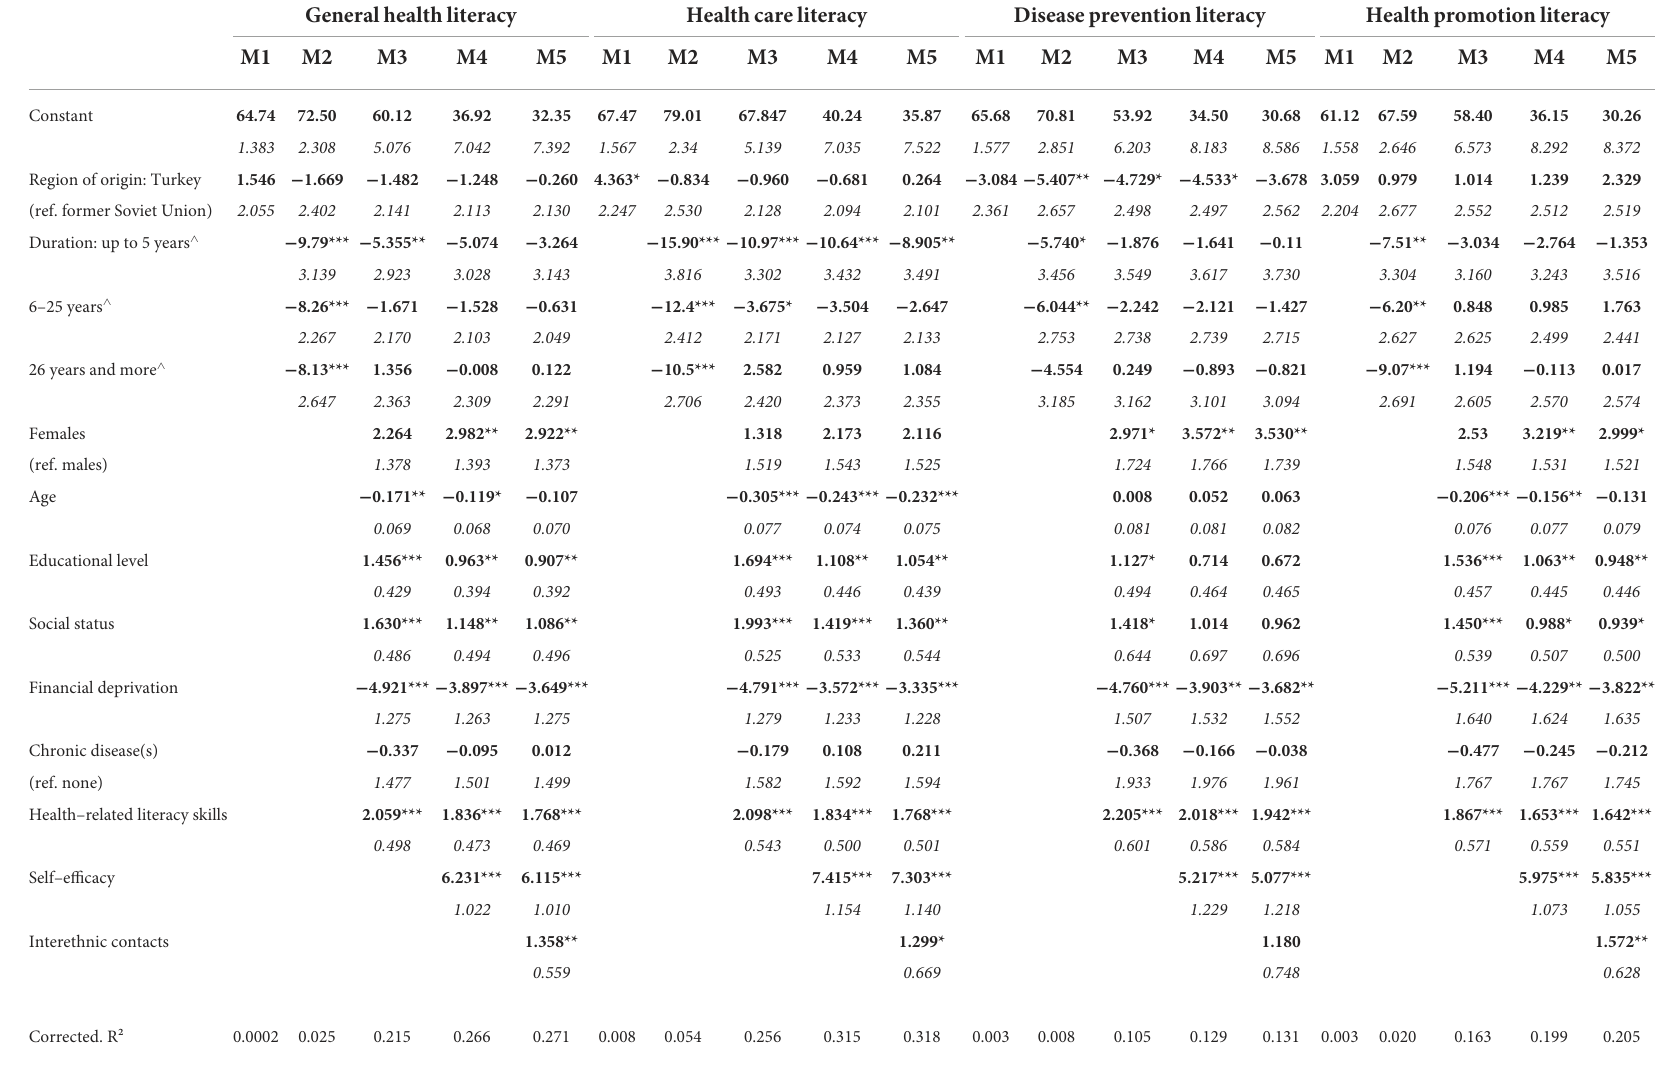
TABLE 2 Factors associated with health literacy—stepwise ordinary least square (OLS) regression